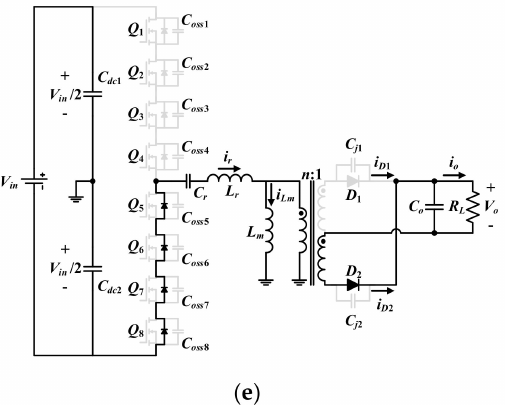
Figure 4. Equivalent circuits for each mode: ( a ) Mode 1; ( b ) Mode 2; ( c ) Mode 3; ( d ) Mode 4; ( e ) Mode